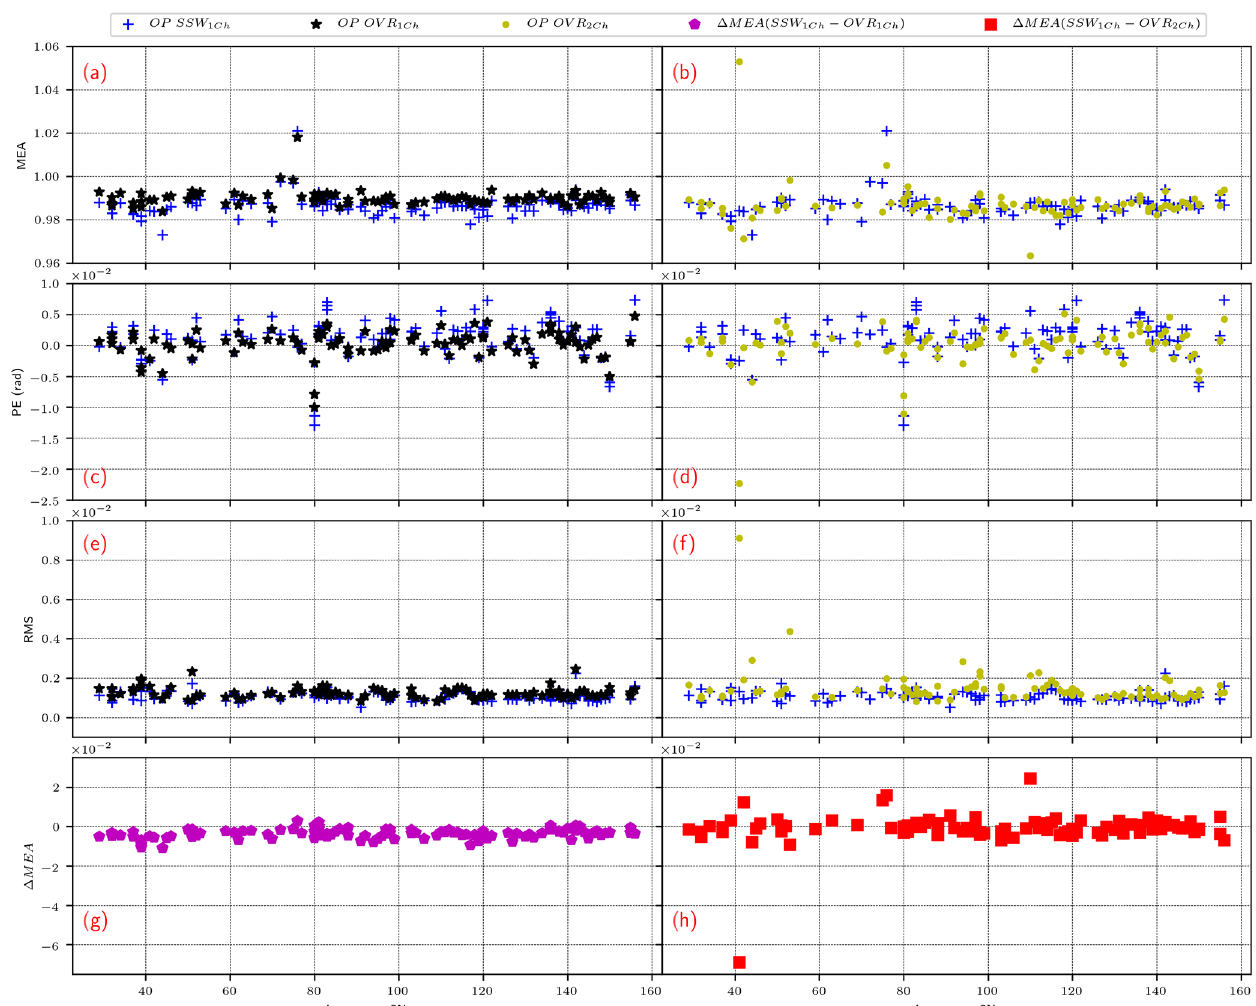
Figure 10. Main results for the main (a, c, e, g) and CO detector channels (b, d, f, h) resulting from the revised open-path method. The modulation efficiency, phase error, rms and relative difference for the first channel by using SSW and OVR are shown in (a) , (c) , (e) and (g) , respectively, while the modulation efficiency, phase error, rms and relative difference for the first and second channels using SSW and OVR are presented in (b) , (d) , (f) and (h) ,